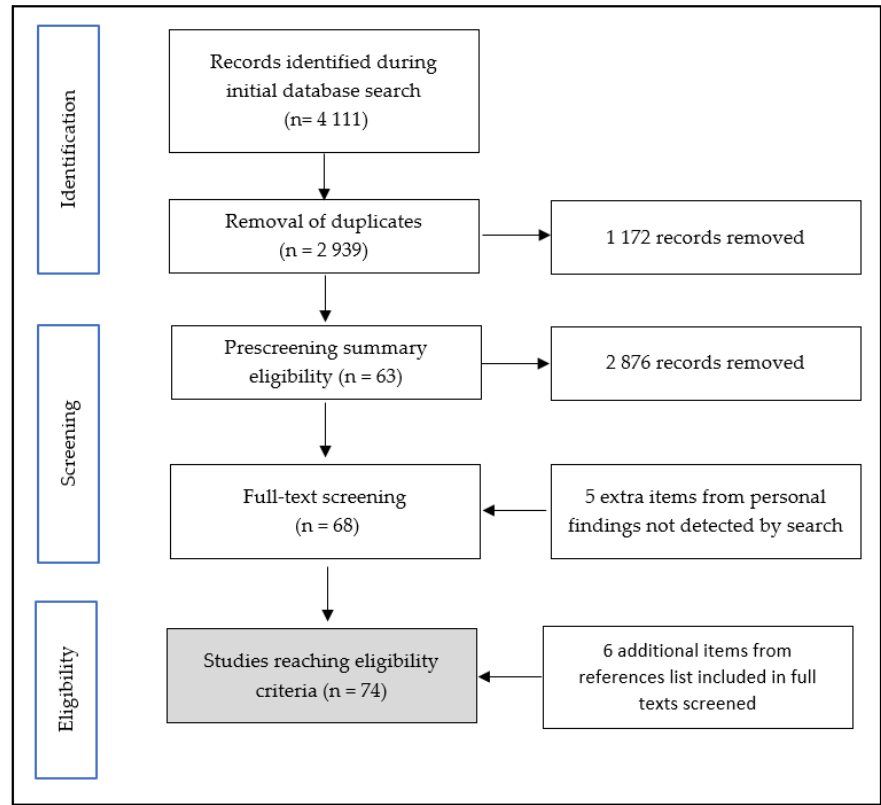
Figure 2. Flowchart of inclusion and screening process for studies’ eligibility.